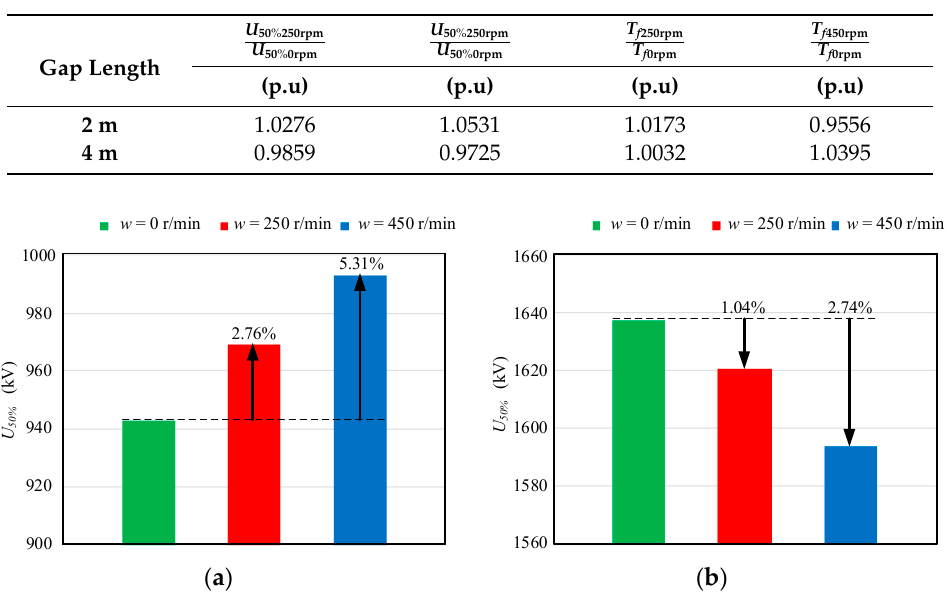
Table 3. Relationship between U 50% and T f ratio under different rotating speeds.